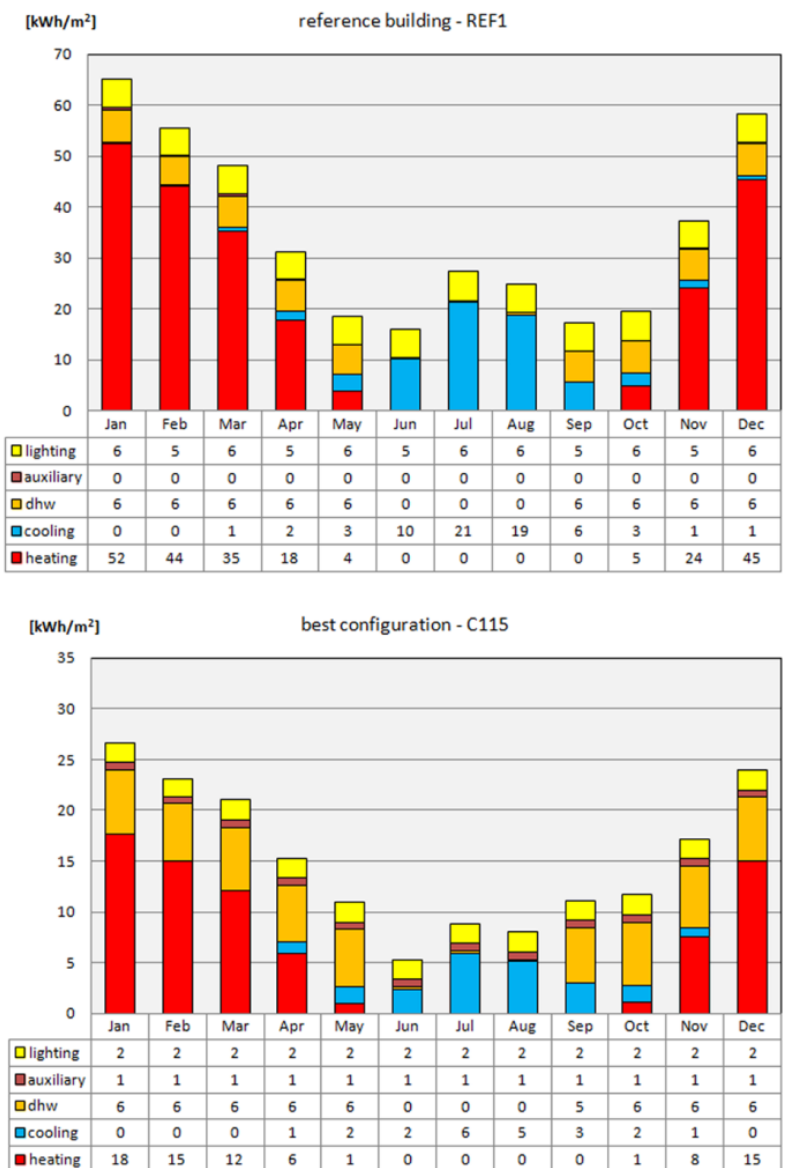
Figure 3. Energy demand of reference building 1 (REF1) and the best configuration (REF1—C-115).